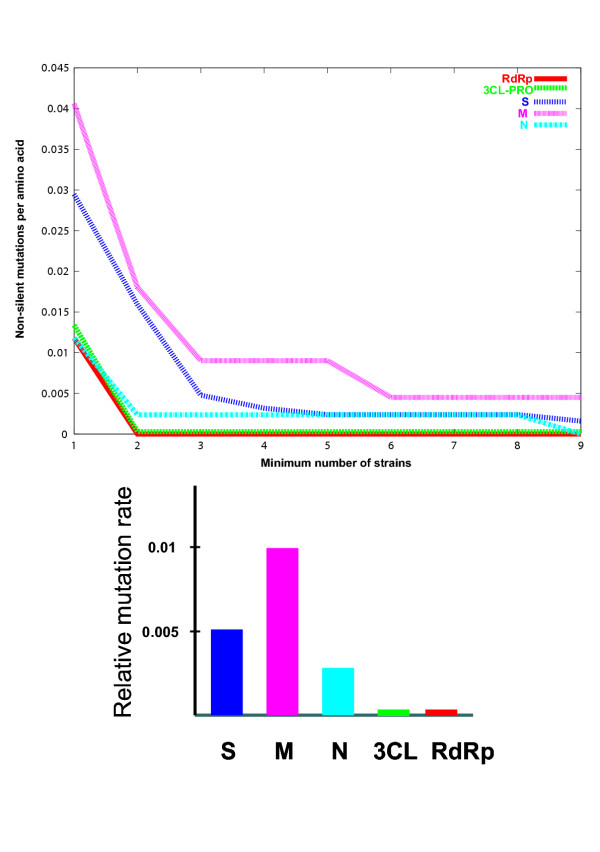
Non-silent variations in five key ORFs. Nucleotide variations that lie within a coding region might result in amino acid variations in the corresponding protein product. Such non-silent variations could play a significant role in determining the survivability of SARS-CoV variants. Application of the proposed variation filter reveals conservation of the polymerase (RdRp) and 3CLpro, which is consistent with previous studies of other Corona viruses.